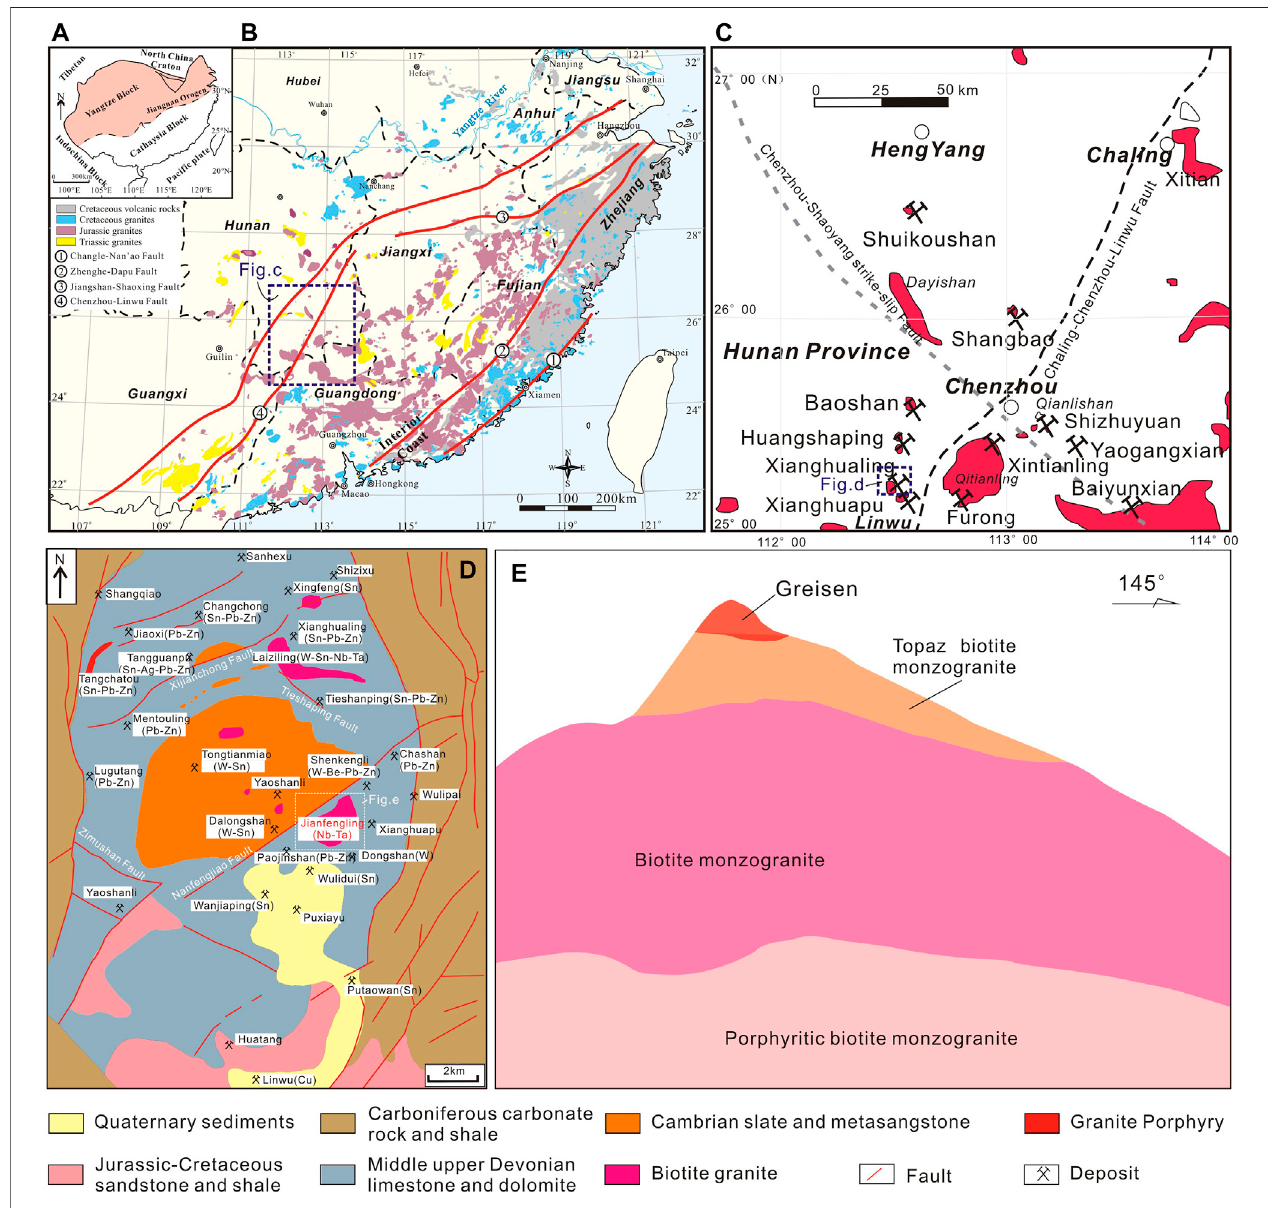
FIGURE 1 | (A,B) Map showing the Jurassic granite distribution in South China (after Wang et al., 2008). (C) Jurassic granites and associated W – Sn – Cu – Pb – Zn polymetallic deposits in southern Hunan (after Yao et al., 2007). Simpli fi ed geological maps of the (D) Xianghualing ore fi eld (after Yang et al., 2013) and (E) Jianfengling granitic pluton (after Chen,